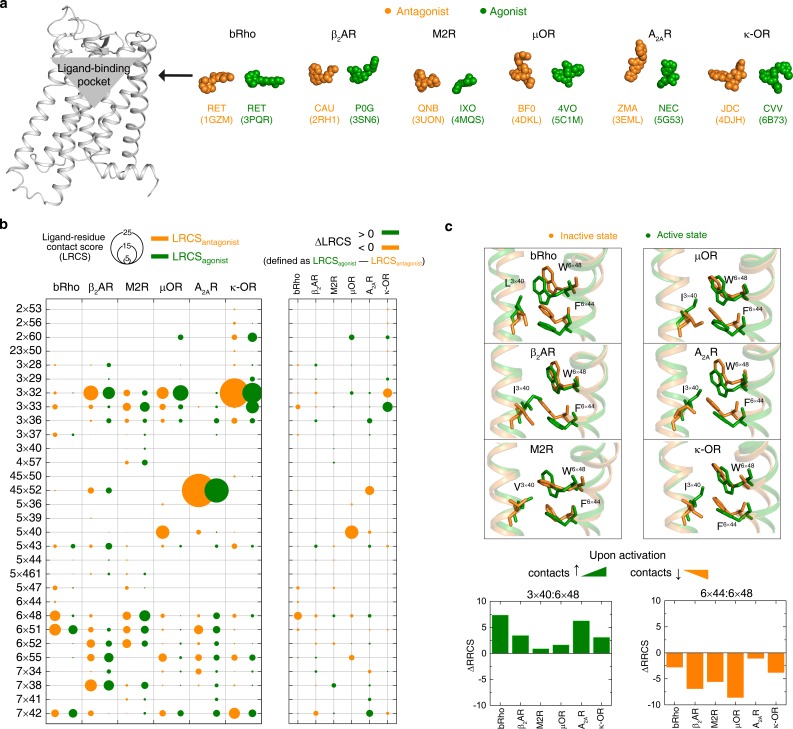
Rearrangements of ligand-residue contacts in ligand-binding pocket are not conserved, reflecting diverse ligand recognition modes.(a) Sphere representation of antagonist- and agonist-bound receptor crystal structures. (b) Diverse LRCS and ∆LRCS reveal the repertoire of ligand recognition across class A GPCRs. The agonist or antagonist was treated as a single residue when calculating LRCS and ∆LRCS. As shown by the calculated ∆RRCS, no ligand-residue pair exhibits conserved rearrangements upon activation. (c) Conserved conformational changes were only observed at the very bottom of ligand-binding pocket (6×48, 3×40 and 6×44).